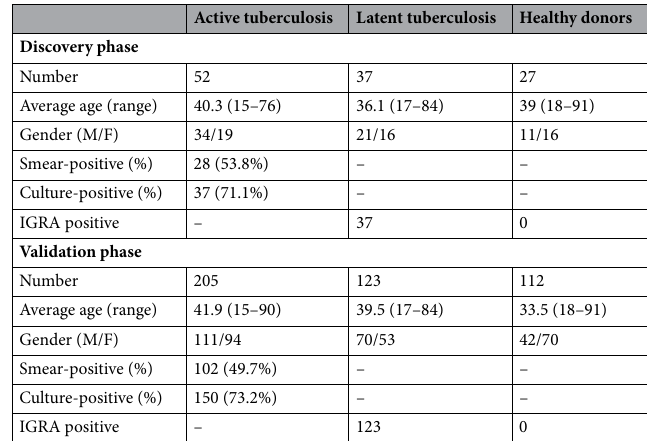
Table 1. Demographic and diagnostic information for the study